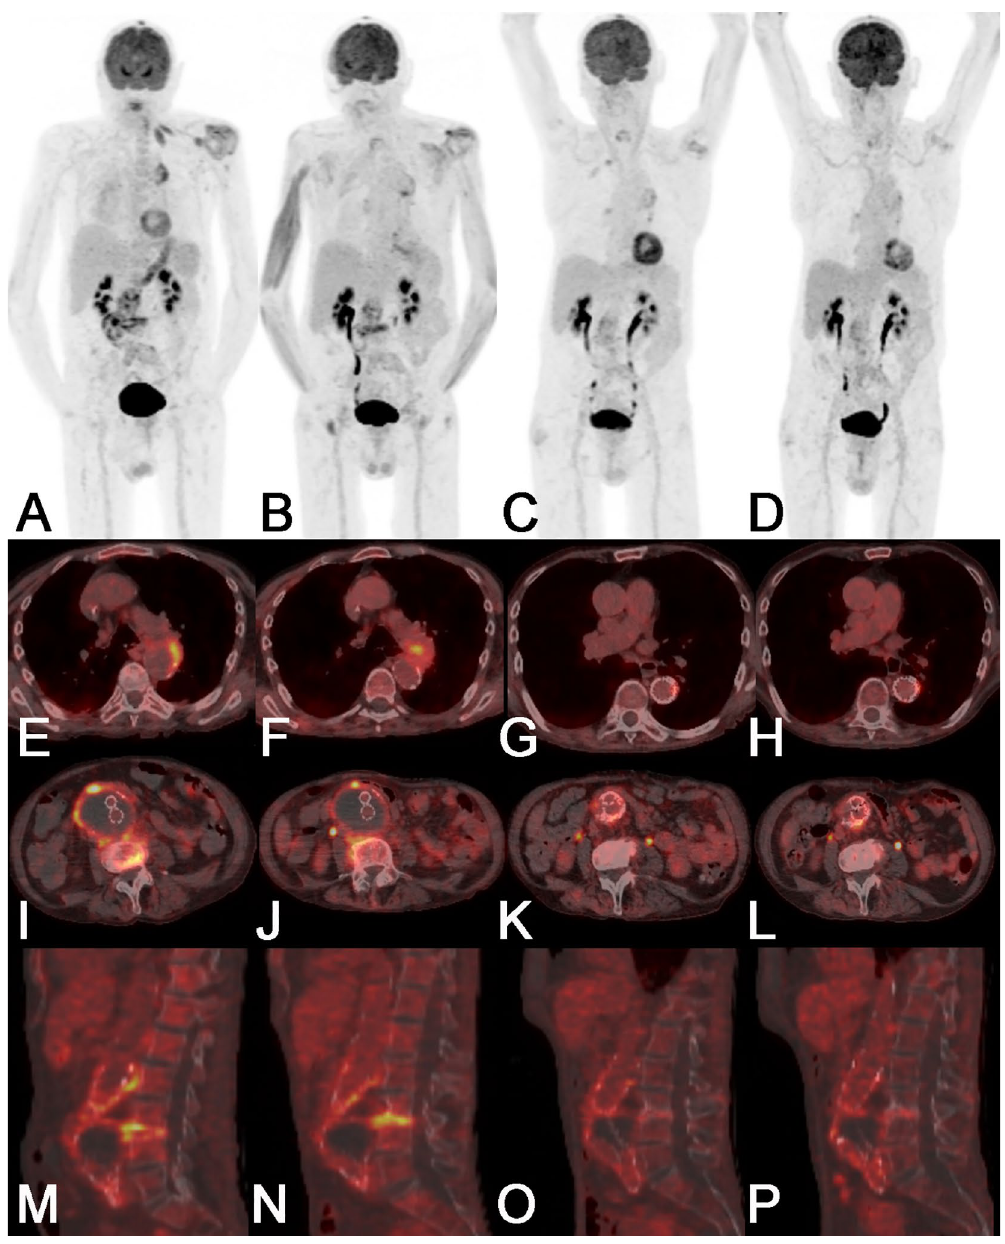
Figure 2. PET/CT of an 82-year old male patient (patient 05 in Tables 1, 2 and 3) with a vascular graft infection and spondylodiscitis due to Streptococcus agalactiae showed a new focal FDG uptake in the wall of the thoracic aorta in September 2017. Both readers rated the thoracic finding as a infective native aneurysm despite the fact that the vessel diameter was not pathologically widened. The first PET/CT follow-up in revealed a progression of the aneurysm in size with stable increased FDG uptake; at the same time the FDG uptake of the spondylodiscitis increased while it partially decreased in the vascular graft infection; C-reactive protein and white blood cell count decreased. After subsequent thoracic endovascular repair with an Endurant II Stent Graft Systems (MEDTRONIC), two further PET/CT follow-up, before and after termination of antimicrobial therapy (223 days of therapy) showed faint residual FDG uptake in all sites of infection. At the last clinical follow-up in January 2019 the patient was in good clinical condition with no sign of infection. Note : Panels A-D show maximum intensity reconstructions of PET; Panels E-P show fused PET/CT images. Abbreviations: PET: positron emission tomography; CT: computed tomography; FDG: